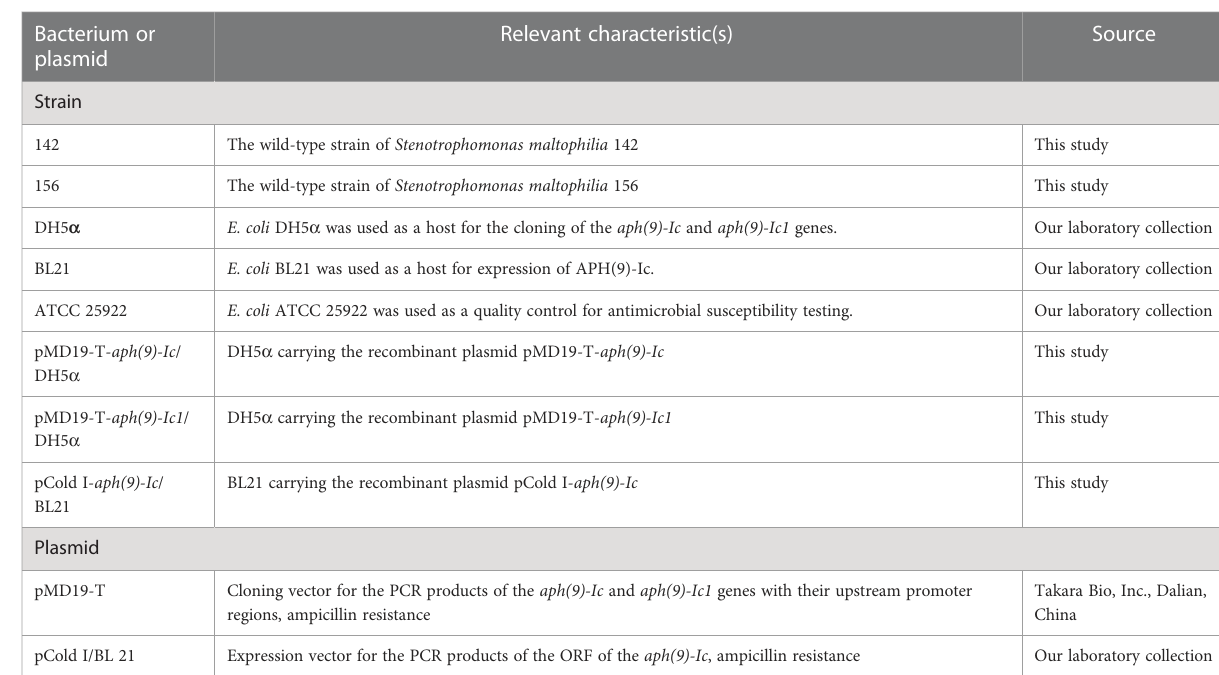
TABLE 1 Bacteria and plasmids used in this